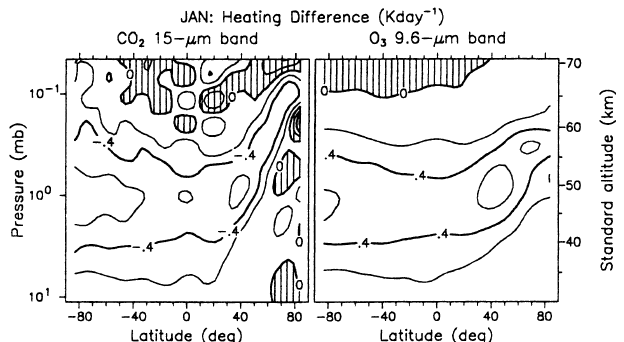
Fig. 6. Heating rate di(cid:128)erence (cid:133) 2 (cid:2) CO 2 (cid:255) Control) for quasi- stationary conditions in January (contour interval 0.2 Kday (cid:255) 1 ):